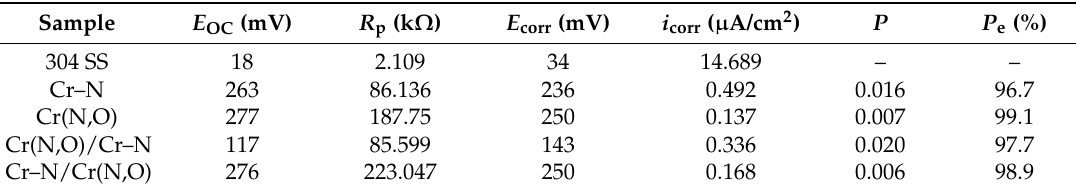
Table 4. Corrosion parameters of Cr-based coatings.